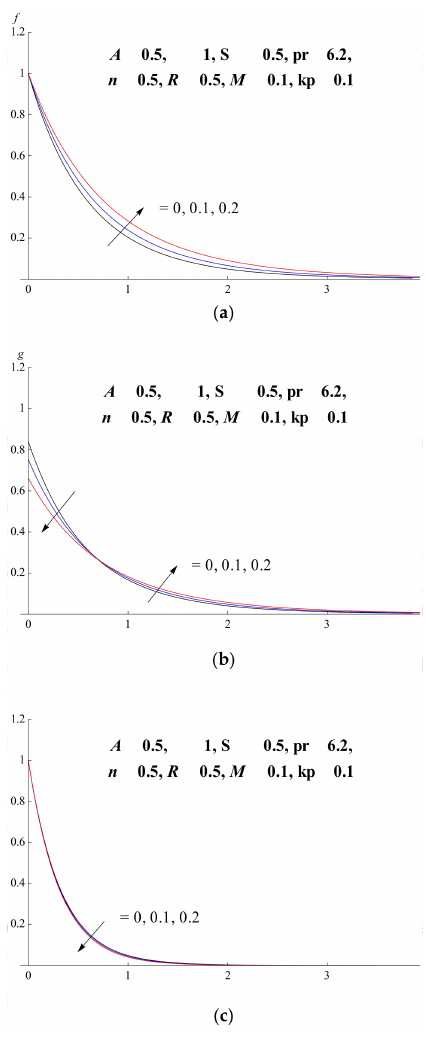
Figure 4. Influence of the nanoparticle concentration. ( a ) Velocity profile, ( b ) angular velocity profile, and ( c ) temperature